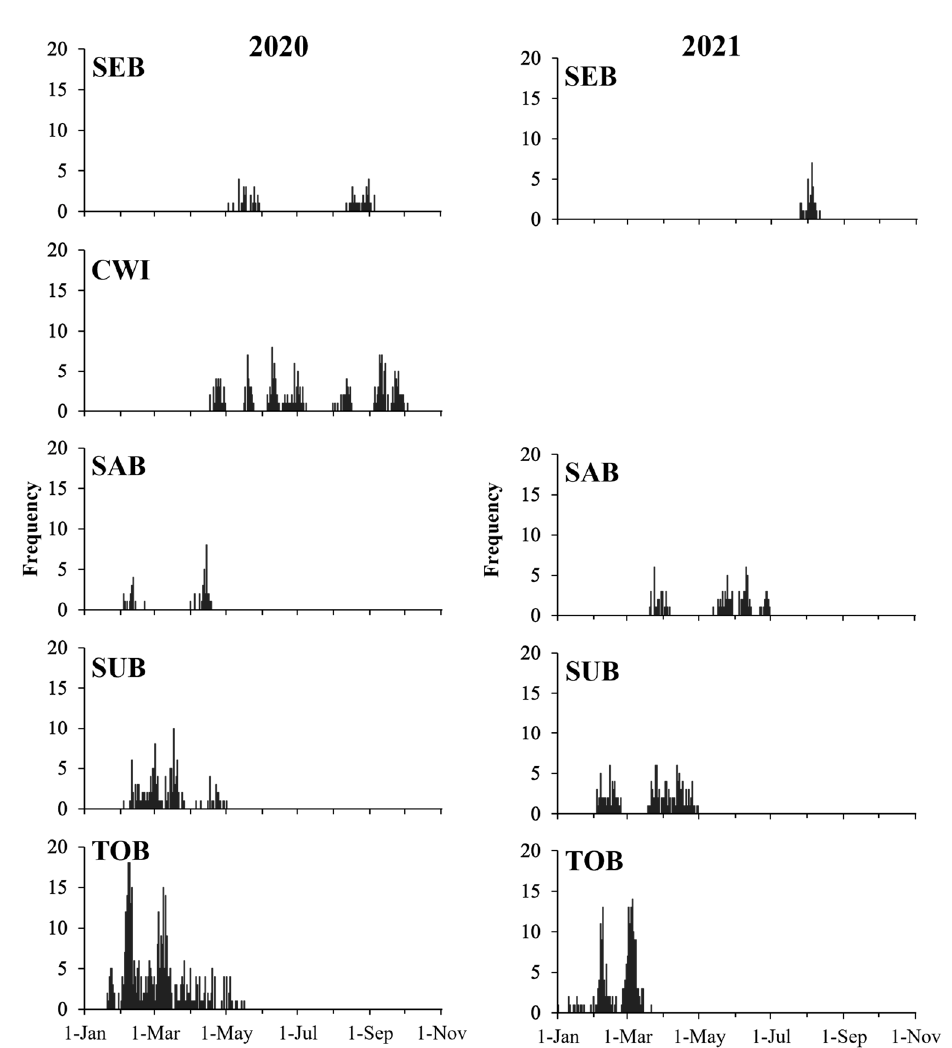
Figure 3. Spawning date distribution of anchovy samples in 2020–2021.